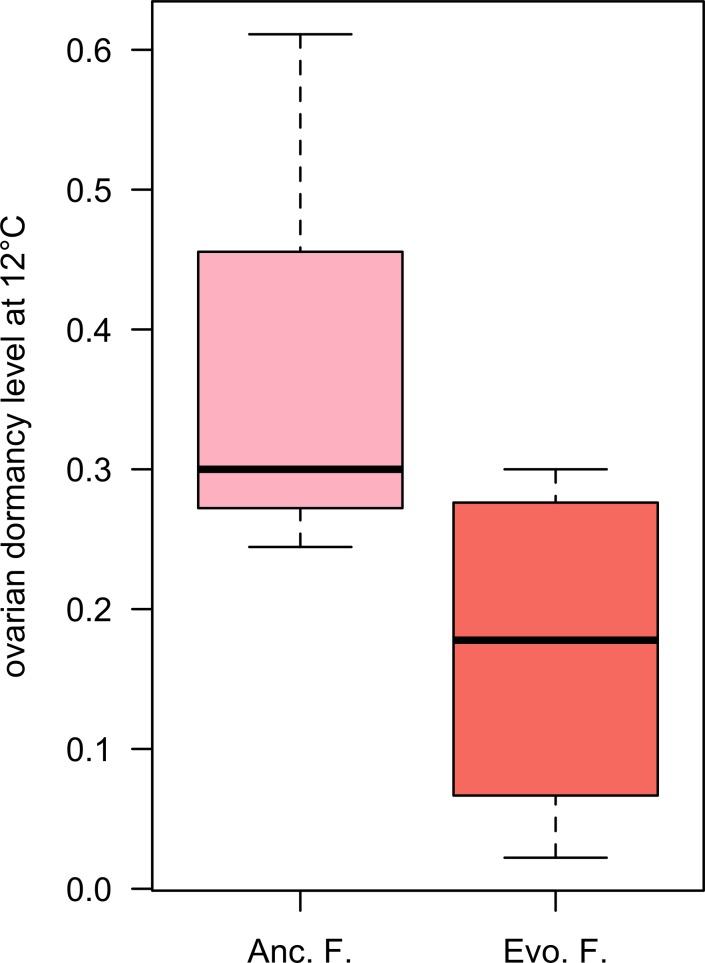
Ovarian dormancy incidence at 12°C.Evolved females have a lower dormancy incidence than ancestral ones (Wilcoxon’s test, W = 3.5, p=0.061).